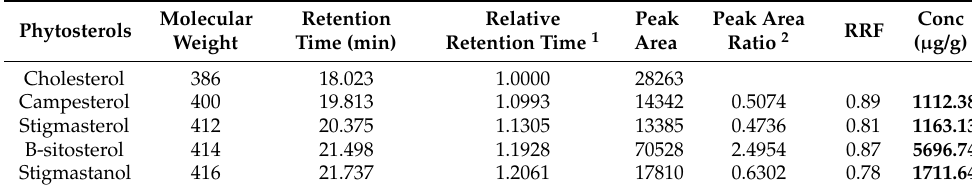
Table 3. The concentration of phytosterols in